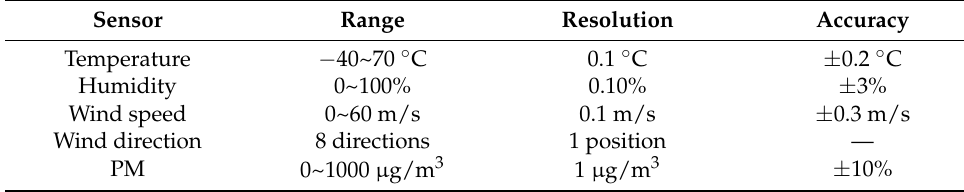
Table 1. Technical parameters of the